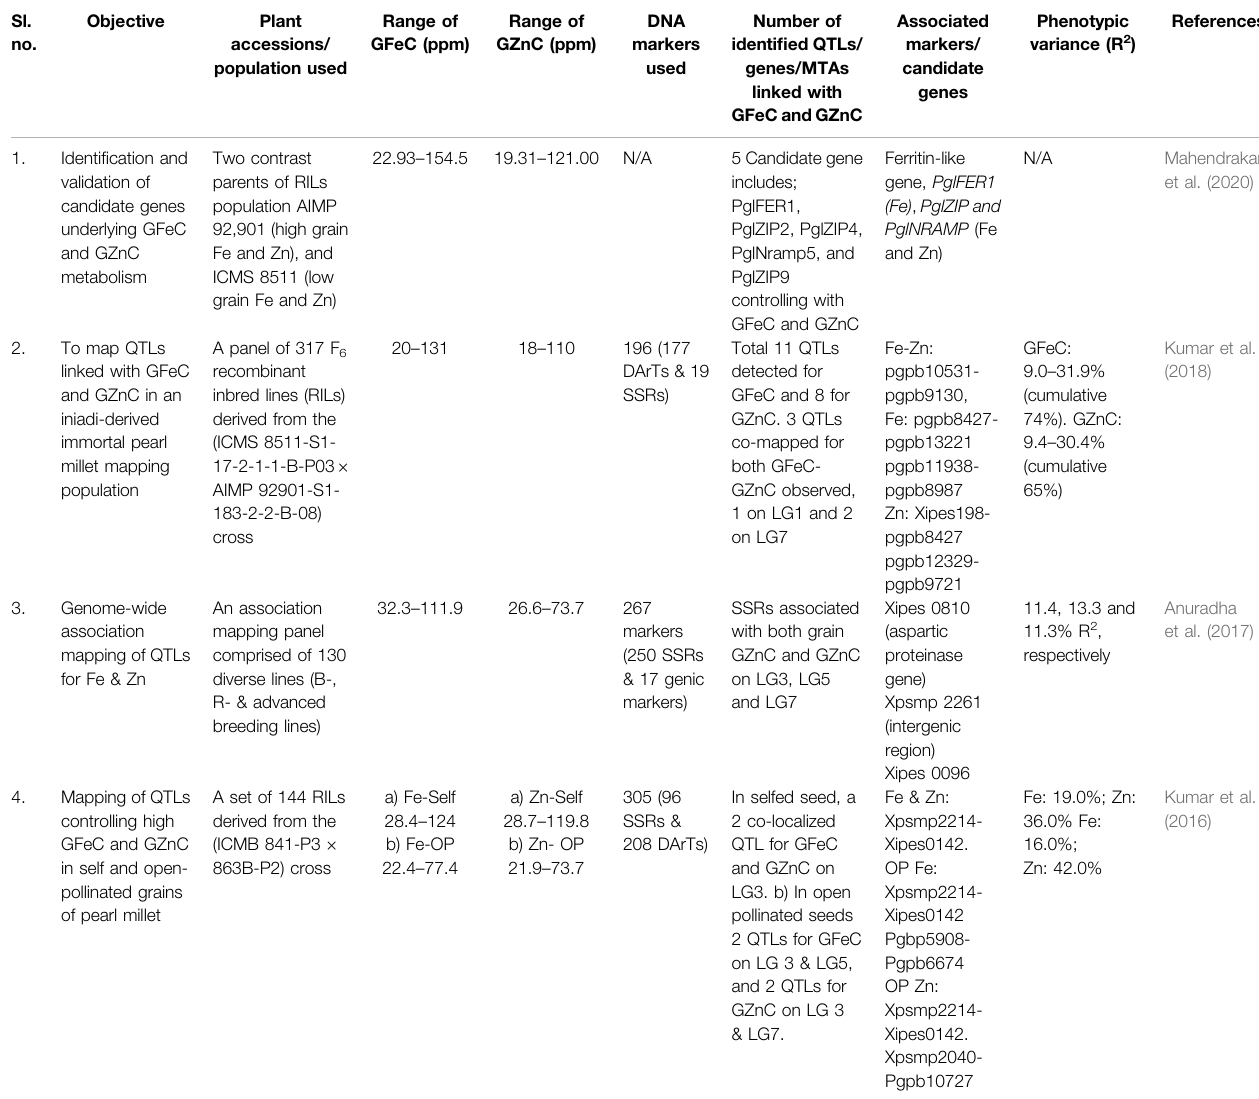
TABLE 1 | Summary of various studies for high grain Fe (GFeC) and Zn (GZnC) content in pearl millet. Sl.